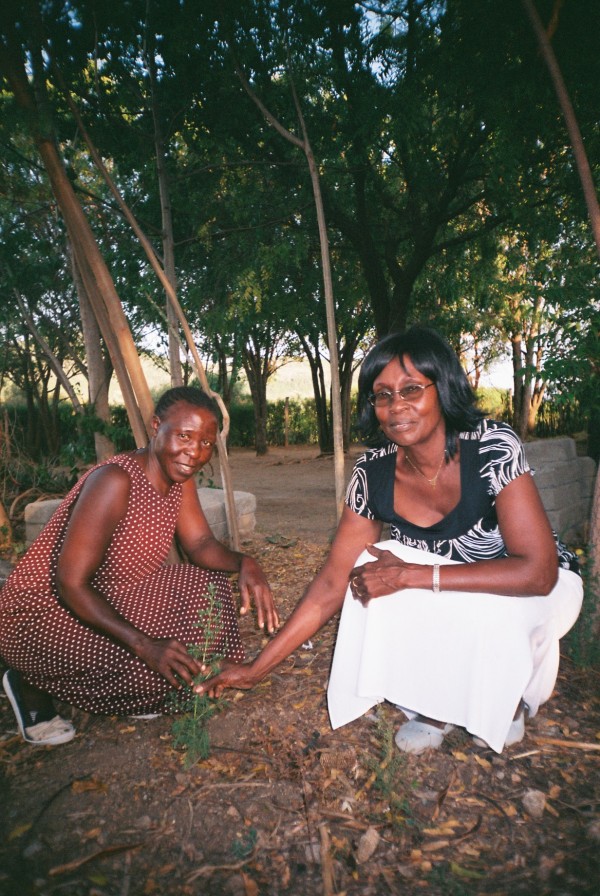
Ester Odhiambo (Rusinga Island, Kenya) demonstrates poor growth of Artemisia annua due to drought.